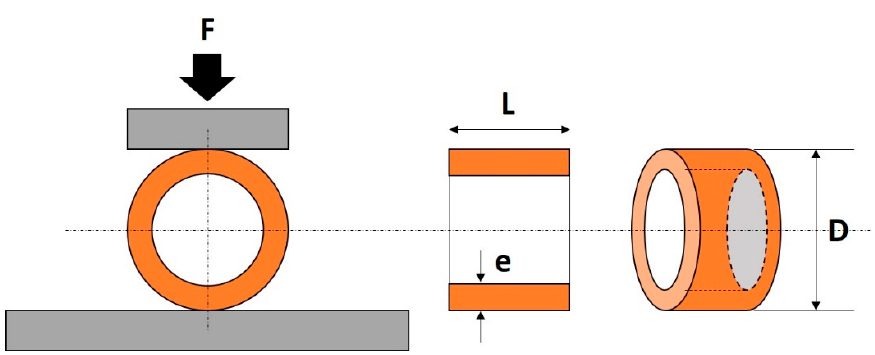
Figure 2. Schematic of compression testing for ring-type ceramics